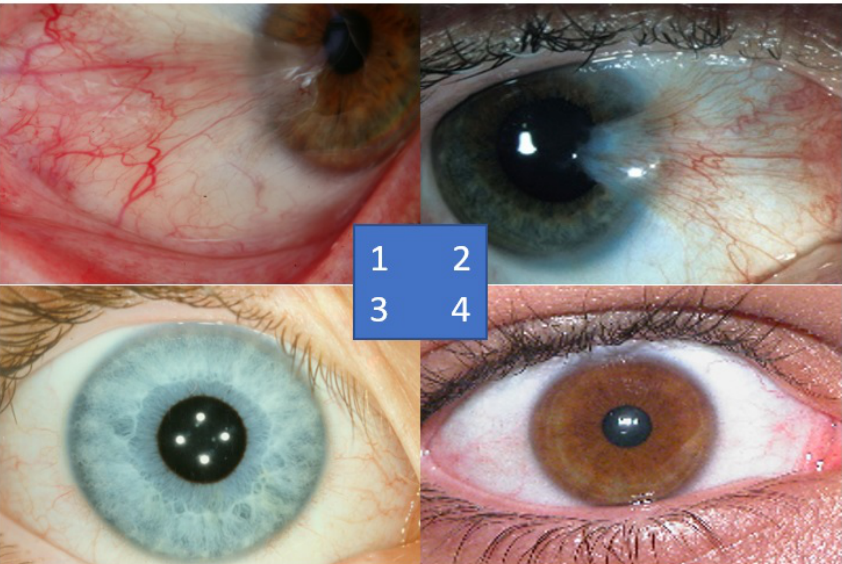
Figure 5. Sample of images from Zaki et al. [19] dataset; sample no. 1 is from the Australian Pterygium dataset, sample no. 2 is from the Brazil Pterygium dataset, sample no. 3 is from the MILES dataset, and sample no. 4 is from the UBIRIS